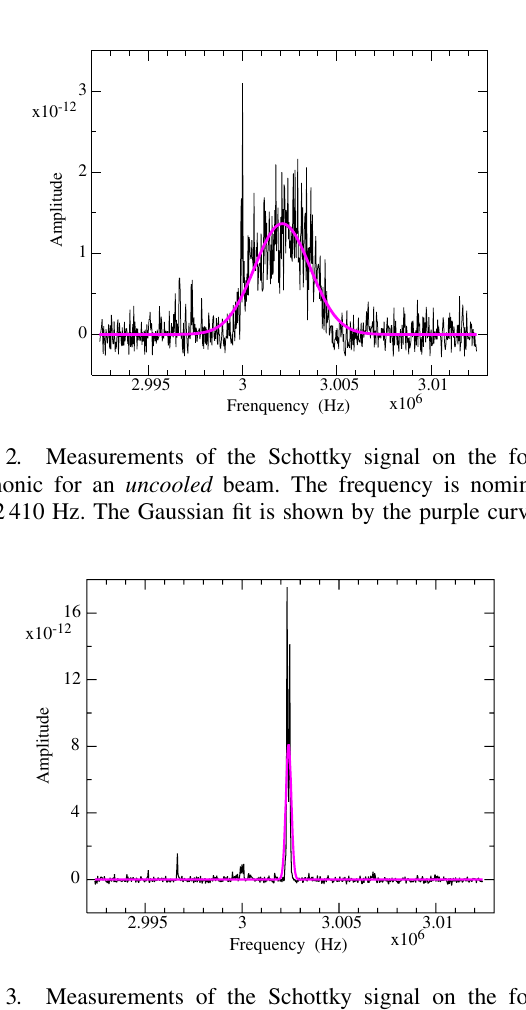
FIG. 3. Measurements of the Schottky signal on the fourth harmonic for a cooled beam. The Gaussian fit is shown by the purple curve.